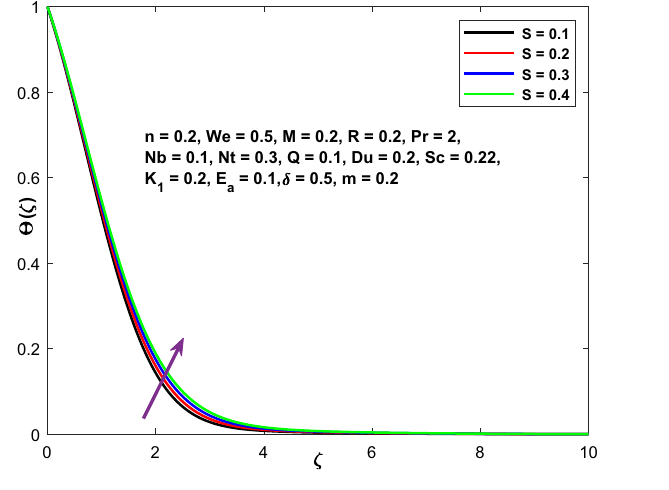
Figure 15. Character of S versus �(ζ) .